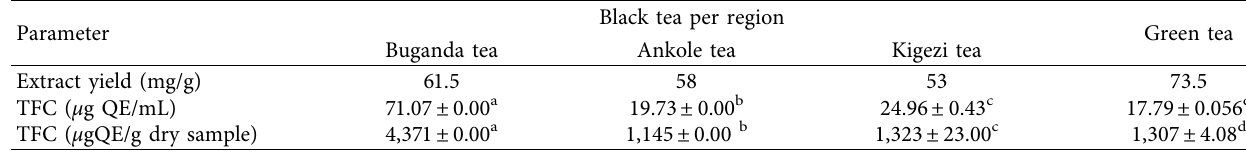
Table 3: Regional/brand diferences in extract yield and total favonoid content (TFC) in μ gQE/g and μ gQE/g dry sample. Parameter Extract yield (mg/g)